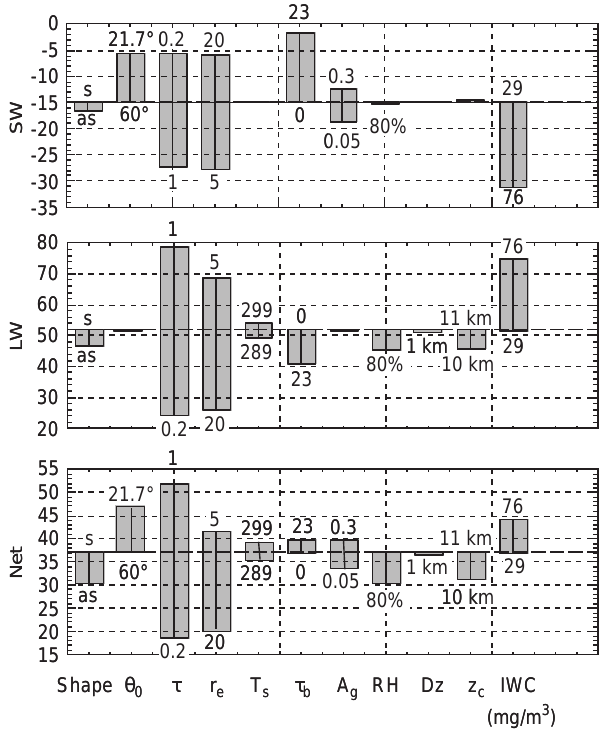
Fig. 6. Results of a sensitivity study using model N. The bars indicate the range of variation of shortwave ( SW ), longwave ( LW ) and net ( Net ) flux changes in Wm ) 2 for 100% contrail cover due to the given variation of the parameters: particle shape, solar zenith angle h 0 , IWC or optical depth s , volume-mean particle radius r (in l m), surface e temperature T (K), optical depth of lower level cloud s b , ground s albedo A g , ambient relative humidity RH (% of liquid saturation), contrail layer depth Dz (km), cloud top level z (km), and contrail at c